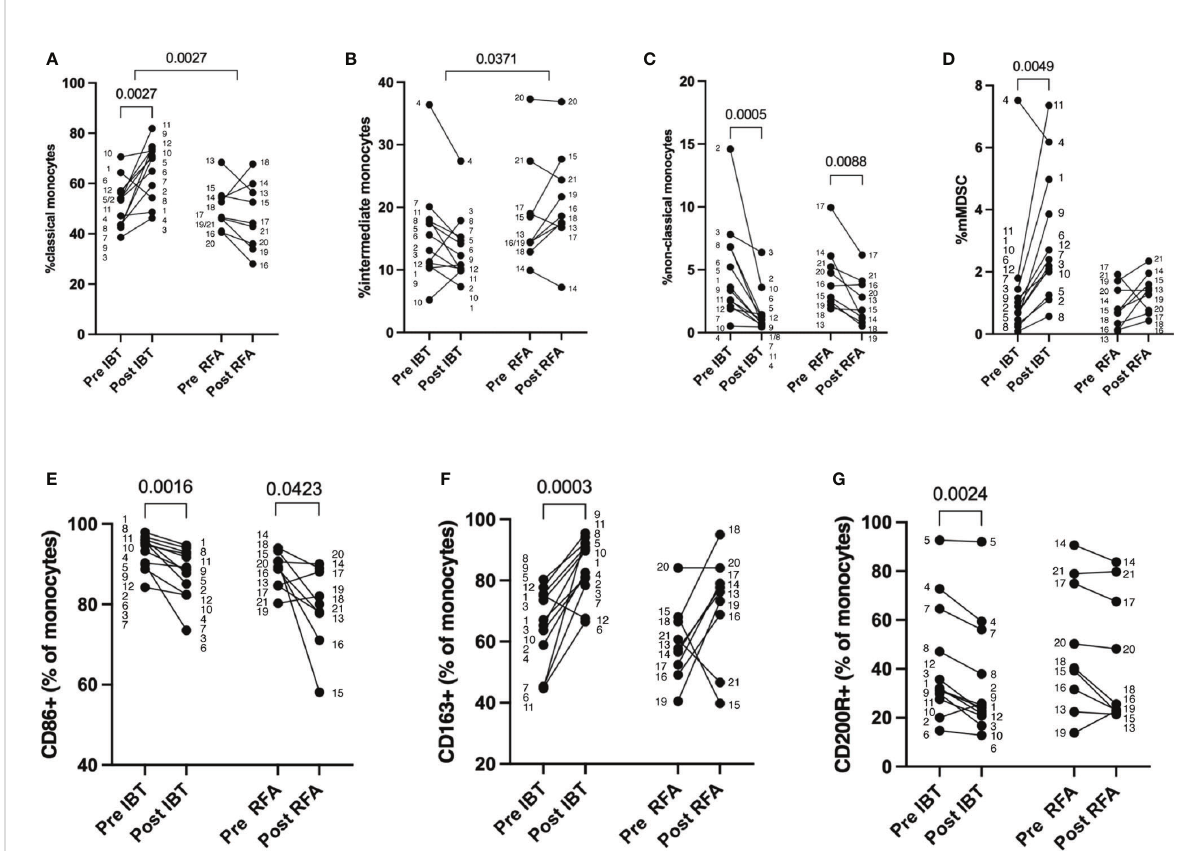
FIGURE 4 Therapy-speci fi c alterations in monocyte cell populations. Percentage of myeloid cells as measured by fl ow cytometry. Pre and post analysis of 12 IBT- and 9 RFA-treated patients. (A) Classical monocytes (CD14++CD16 − ), (B) intermediate monocytes (CD14++CD16+), (C) non-classical monocytes (CD14+CD16++), (D) mMDSC, (E) CD86+, (F) CD163+, and (G) CD200R+ monocytes (shown as percentage of monocytes). Each dot represents an individual patient. Numbers next to dots represent patient IDs and ensure assignment of pre and post values. Data were analyzed using paired t -test (IBT: A, F ; RFA: A, C – F ) or Wilcoxon test (IBT: B – E, G ; RFA: B, G ). Intraindividual differences were analyzed using unpaired t -test (A, B, D, E) or Mann – Whitney U -test (C, F, G) . p -values < 0.05 indicate statistical signi fi